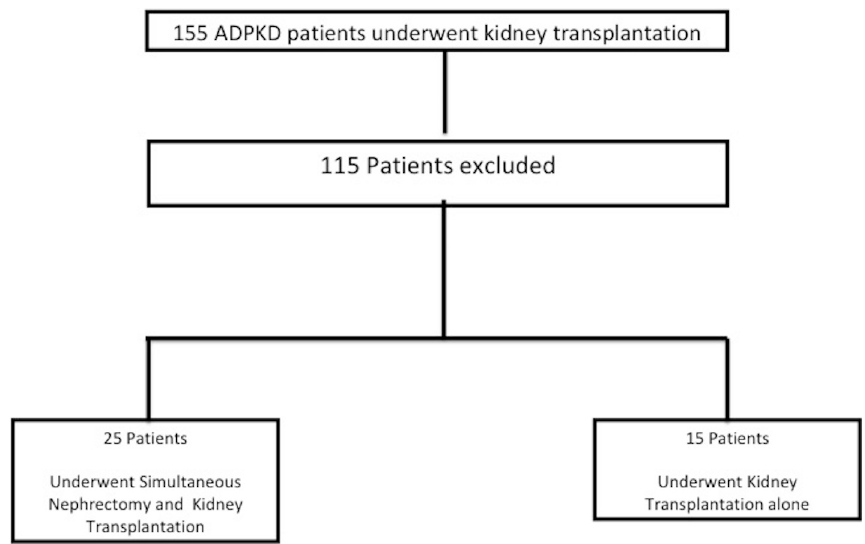
Fig 1. Flow chart of the study enrollment. Patients were excluded if they had only an image before, image was over six months before transplantation, underwent bilateral nephrectomy before transplantation, had concurrent cyst hemorrhage, infection or abscess, were unable to perform MRI, had less than 20 mL/min of eGFR at the time of last imaging, underwent combined transplantation and underwent second transplantation.